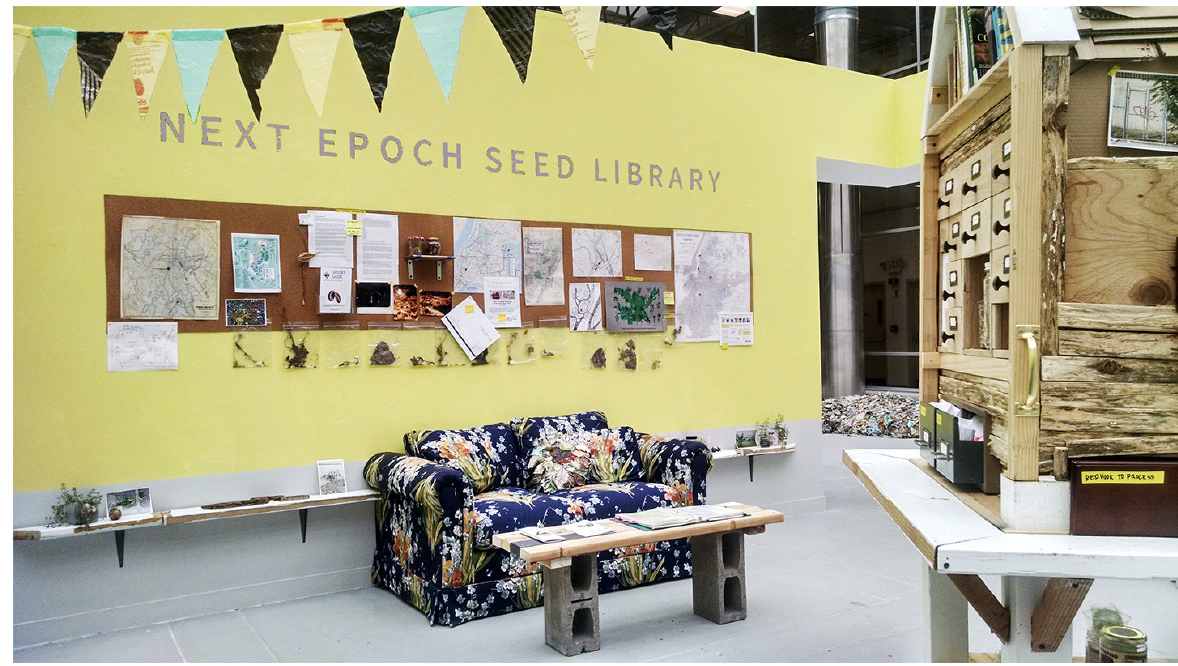
Figure 3: A second view of NESL’s library installation at William Paterson University. Visible here are the reading area and the community bulletin board. Photograph courtesy of Anne Percoco, Next Epoch Seed